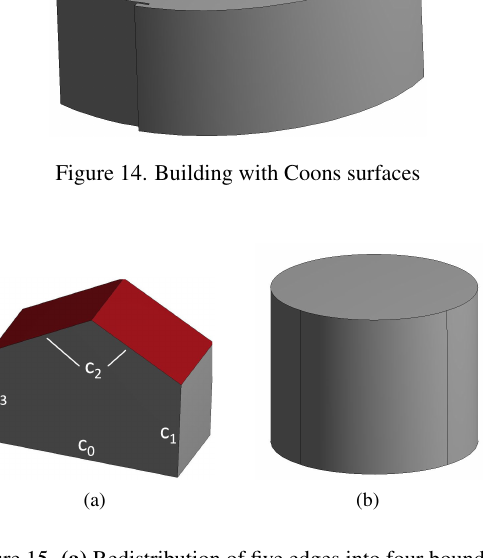
Figure 15. (a) Redistribution of five edges into four boundary curves (b) Lateral surface of a cylinder divided into several